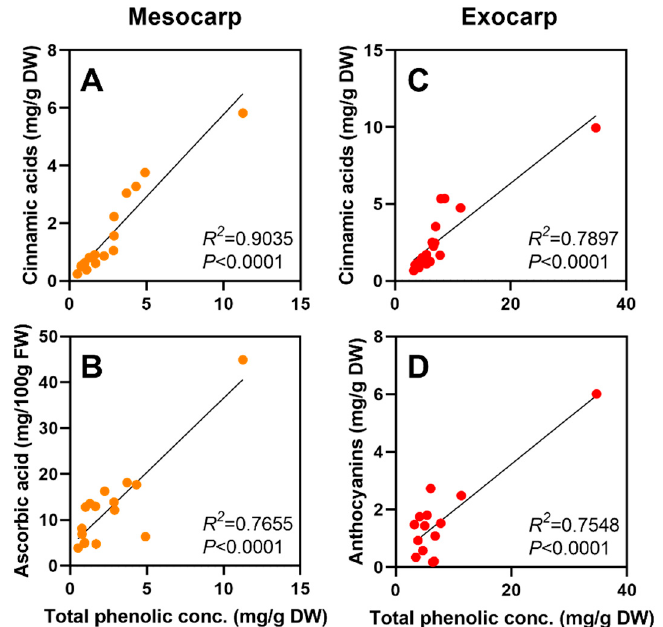
Figure 5. Relationships of total phenolic concentration (TPC) with mesocarp and exocarp characteristics. Cinnamic acids and ascorbic acid demonstrated the highest relationships with TPC across the genotypes in the mesocarp ( A , B ). Cinnamic acids and anthocyanins demonstrated the highest relationships with TPC across the genotypes in the exocarp ( C , D ).